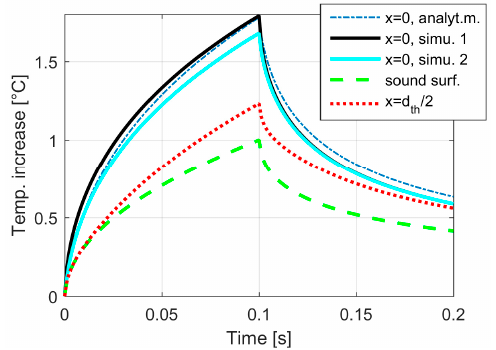
Figure 2. Temperature increase at the crack position ( x = 0), at the sound surface far away from the defect, and at the position x = d th /2, compared with the three models for the same case as shown in Figure 1.